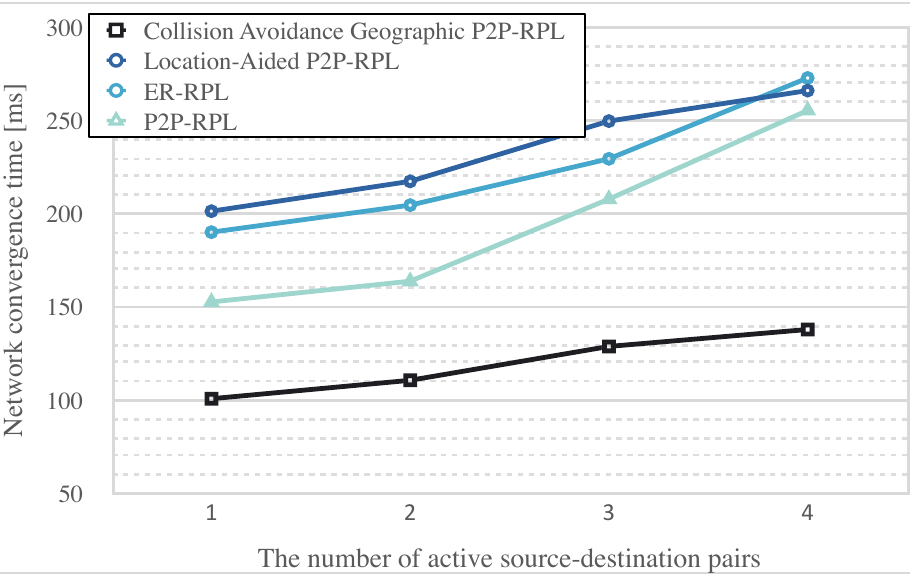
Figure 13. The network convergence time versus the number of active source-destination pairs. Figure 14 shows that, as the number of active source-destination pairs increased, the number of control packet overhead increased. As the number of active source-destination pairs increased, the link losses caused by packet collisions increased. If the node on the shortest path from the source node to the destination node failed to send the DIO control packet to the intermediate nodes, the node retransmitted the DIO control packet in the next interval, thus, resulting in increased control packet overhead. Collision Avoidance Geo- graphic P2P-RPL achieved average 13.0%, 54.8%, and 80.7% less control packet overhead compared with Location-Aided P2P-RPL, ER-RPL, and P2P-RPL, respectively. The decrease in network convergence time means that P2P-DRO packets sent by the desti- nation node finished the P2P route discovery procedure much faster. This reduced the number of P2P-DIO control packets for the amount of reduced network convergence time. The net- work convergence time difference of 114 ms between Location-Aided P2P-RPL and Collision Avoidance Geographic P2P-RPL led to additional DIO control packet